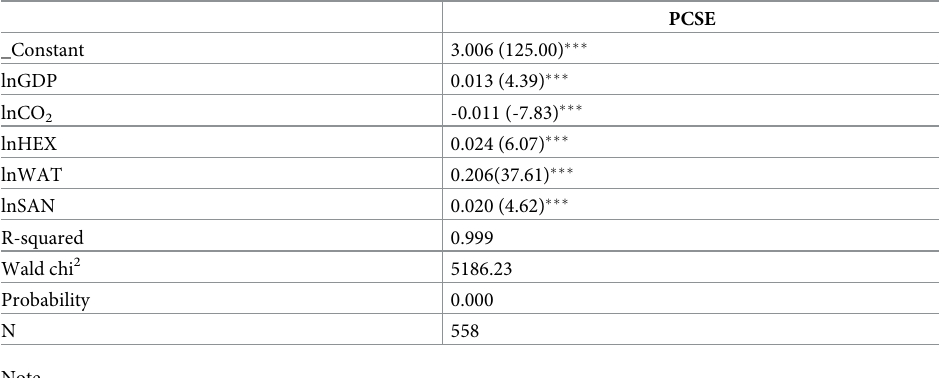
Table 4. The results of PCSE